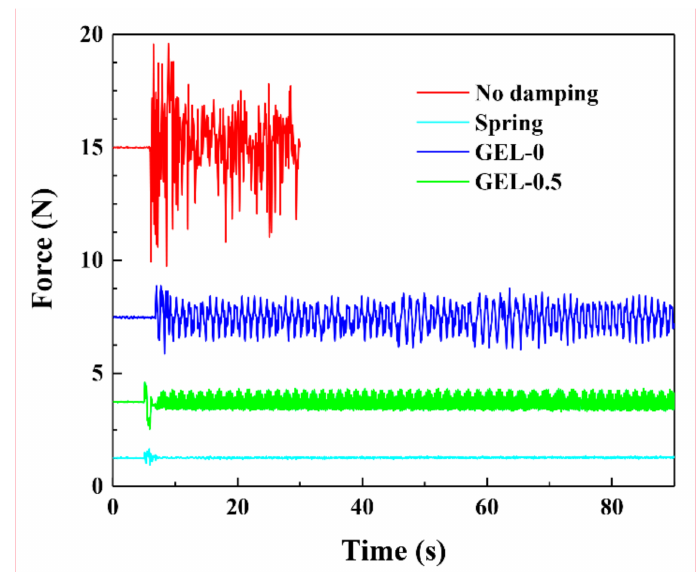
Figure 8. Comparison of the damping e ff ect of di ff erent vibration